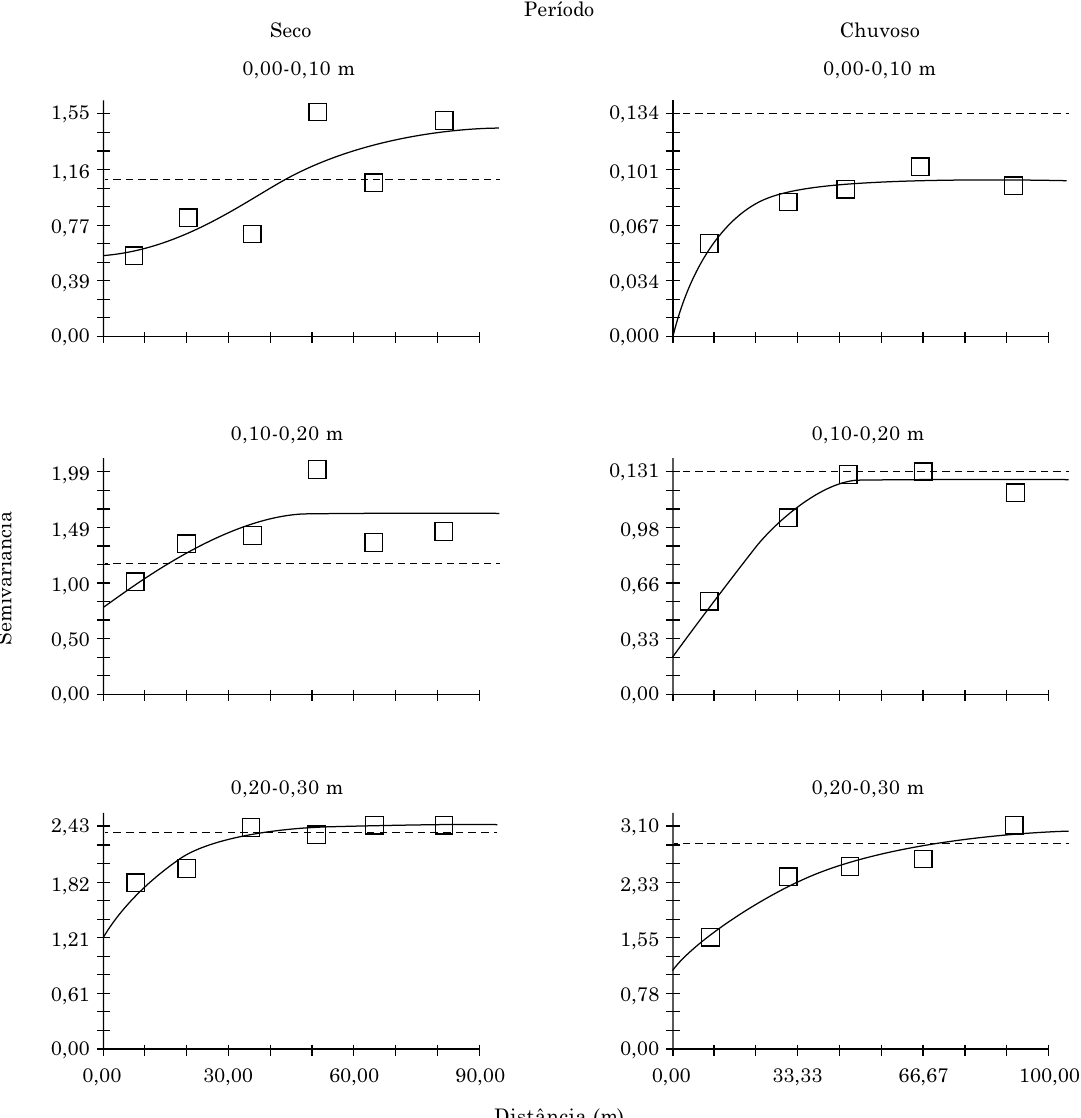
Figura 2. semivariogramas com modelos ajustados aos dados da resistência à penetração (rp) nas três profundidades analisadas (0,00-0,10; 0,10-0,20 e 0,20-0,30 m) nos períodos seco e chuvoso.